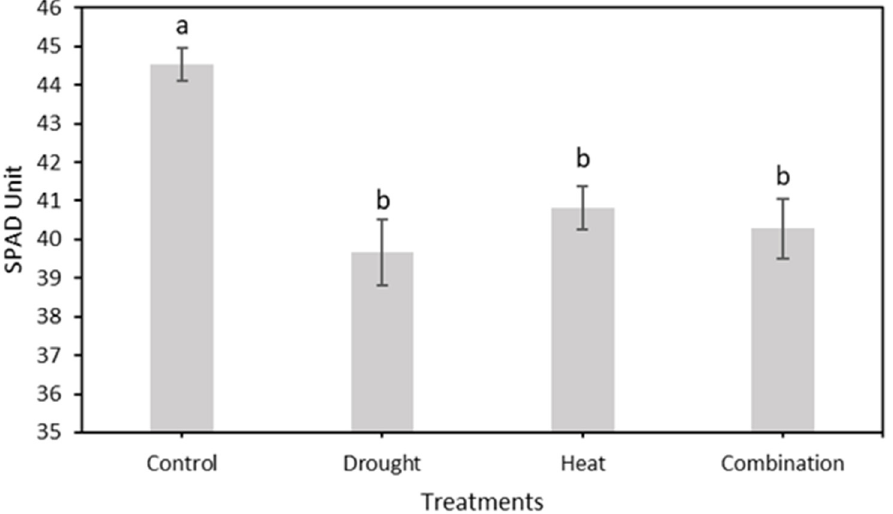
Figure 10. The mean value of relative chlorophyll content (SPAD value) from the total observation period in four treatment groups using a conventional system. The SNK test showed no significant difference between the means represented by the same letter at p ≤